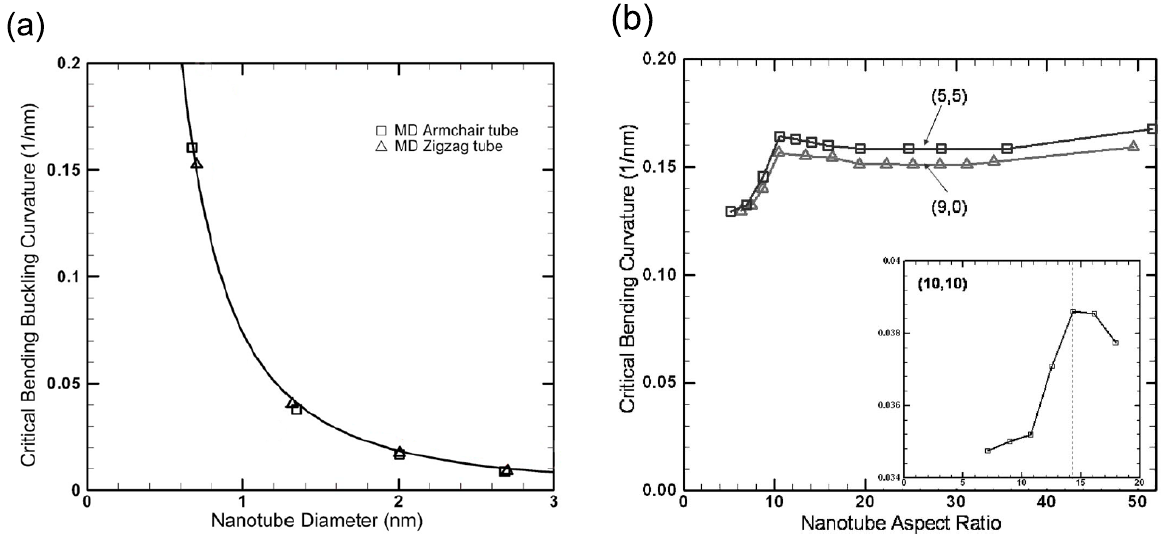
Figure 10. ( a ) Relationship between critical bending buckling curvature κ diameter d obtained from MD analyses. The tube length is fixed at 24 nm; ( b ) The length/diameter ( L/d ) aspect ratio dependence of κ and (10,10). Reprinted from Reference